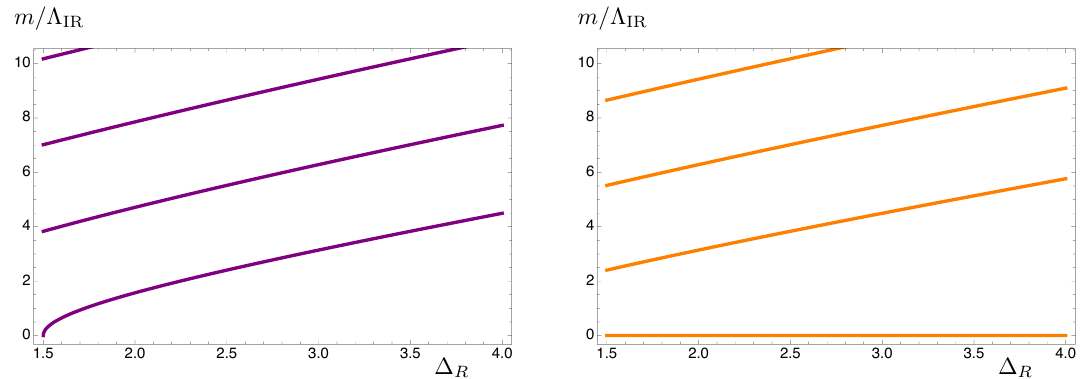
Figure 1 . AdS background. Spectrum of fermionic resonances as a function of ∆ R normalised to the IR scale Λ IR . The left panel shows the poles extracted from the correlator hO R ( q ) O R ( − q ) i + while the right panel shows the poles of hO R ( q ) O R ( − q ) i −